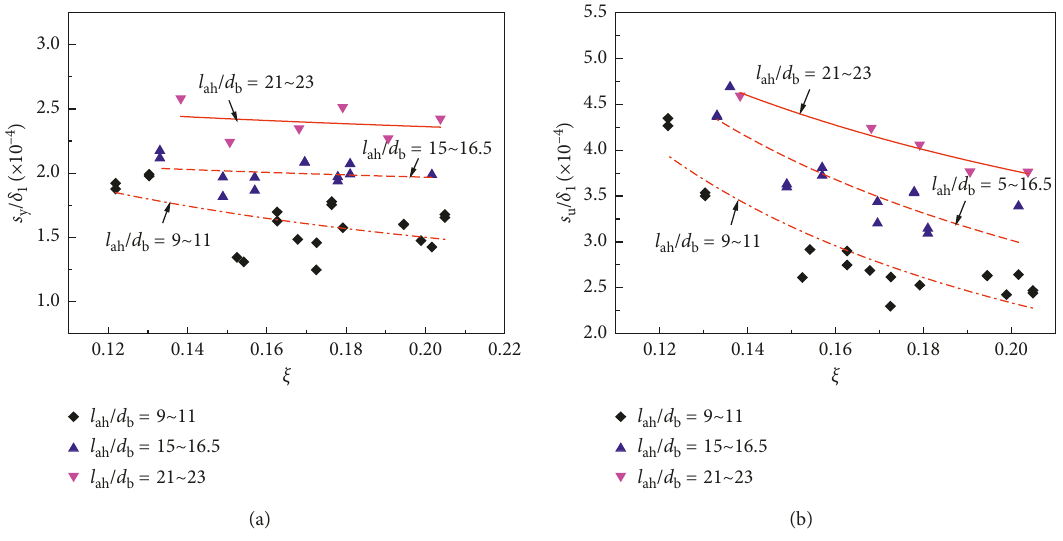
Figure 16: Effect of ξ on (a) s